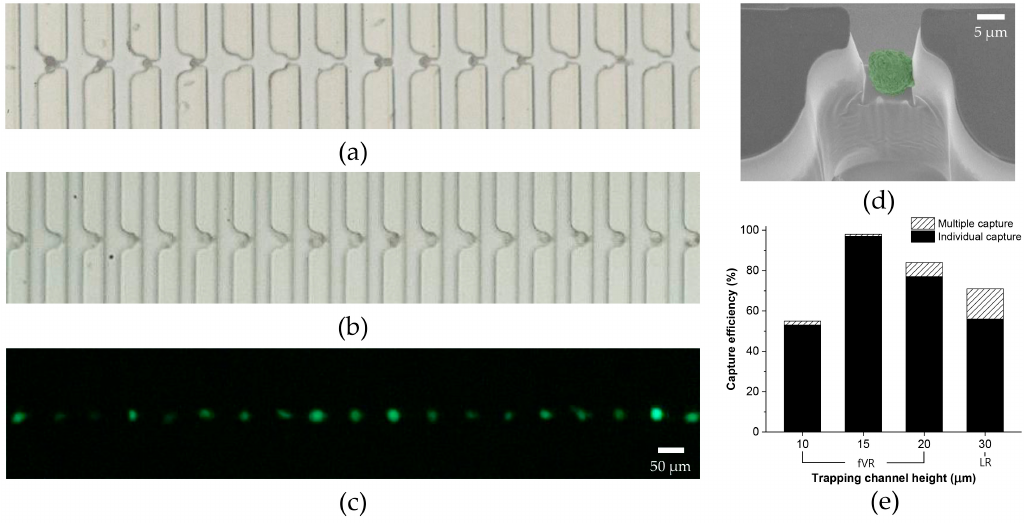
Figure 5. Demonstration of the deterministic cell capture using LM2 MDA-MB-231: ( a ) bright field image of the tumor cell capture using an LR-type device; ( b ) bright field image and ( c ) fluorescent image of the individual tumor cell capture using an fVR-type device; ( d ) SEM image of a captured tumor cell from the fVR-type device; ( e ) capture efficiency of the LR- and fVR-type devices regarding various trapping channel heights. The graph also includes the individual capture rate.